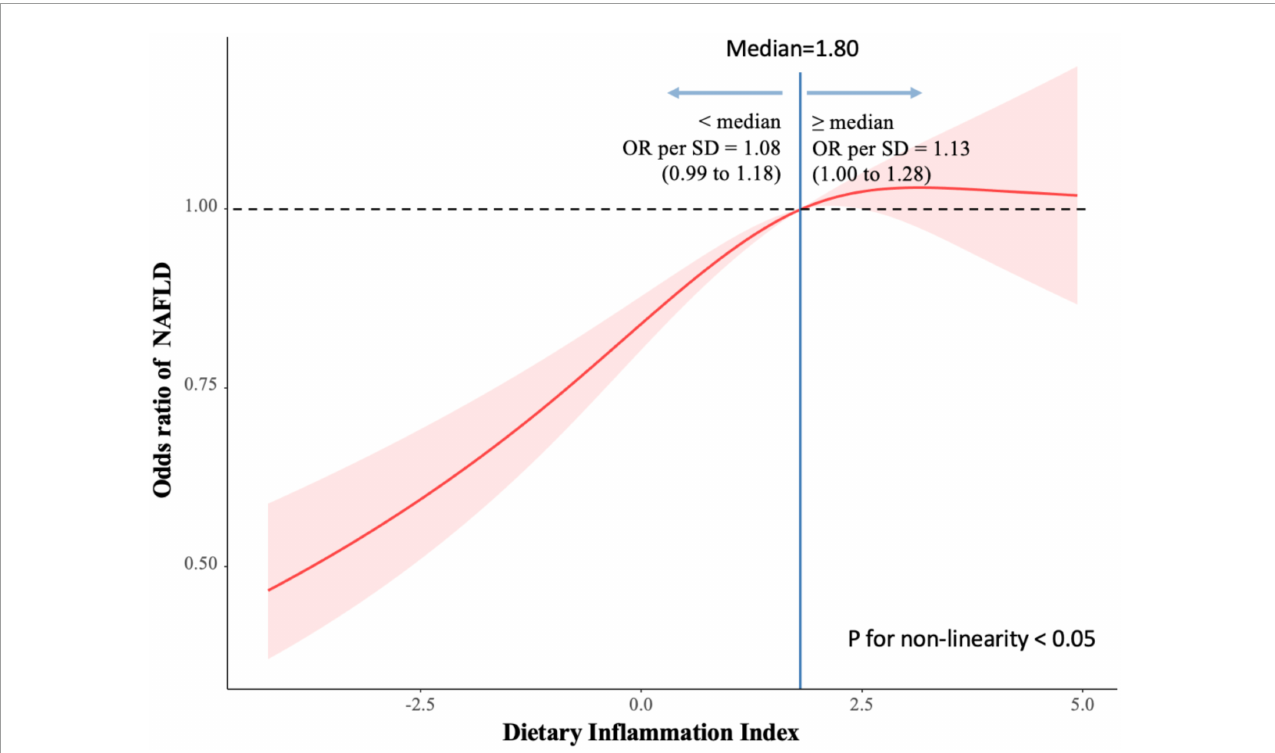
FIGURE2 Association of dietary inflammatory index (DII) and non-alcoholic fatty liver disease (NAFLD) among adults. Reference point is median for NAFLD, with knots placed at 10th, 50th, 90th centiles of NAFLD distribution.